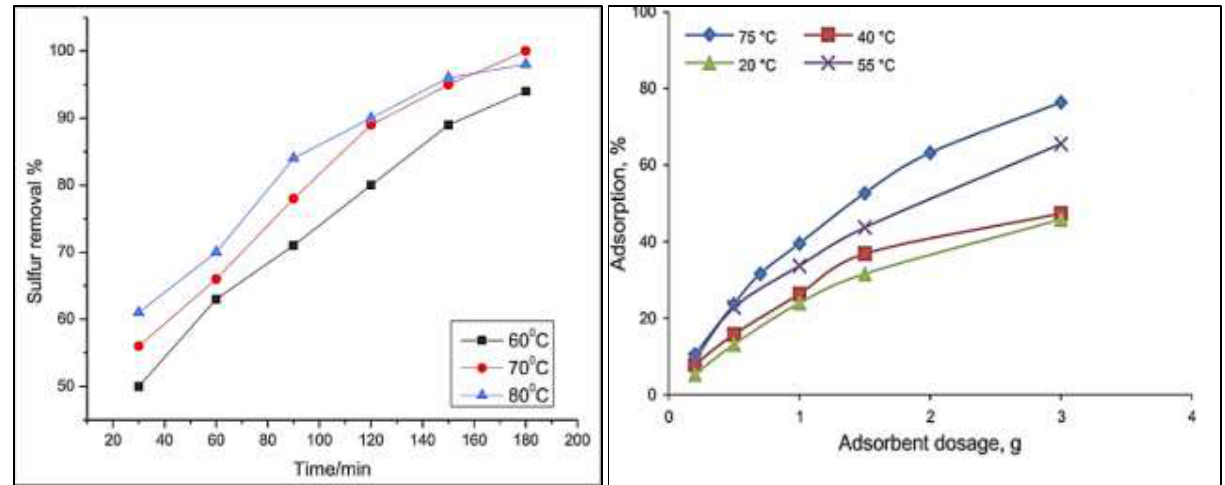
Figure 5: The effect of time, adsorbent dose, and temperature on the removal efficiency of sulfur compounds [33,